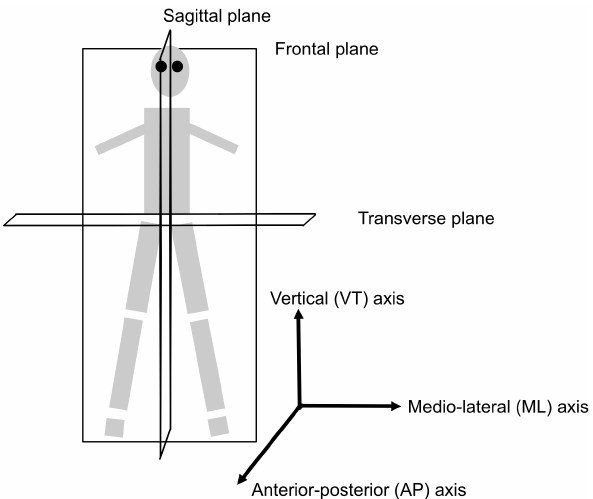
Figure 1. Axes of rotation and anatomical planes. The frontal plane (coronal plane) is dividing the body into anterior and posterior sections, the sagittal plane is dividing the body into left and right sections and the transverse (horizontal) plane is dividing the body into upper and lower